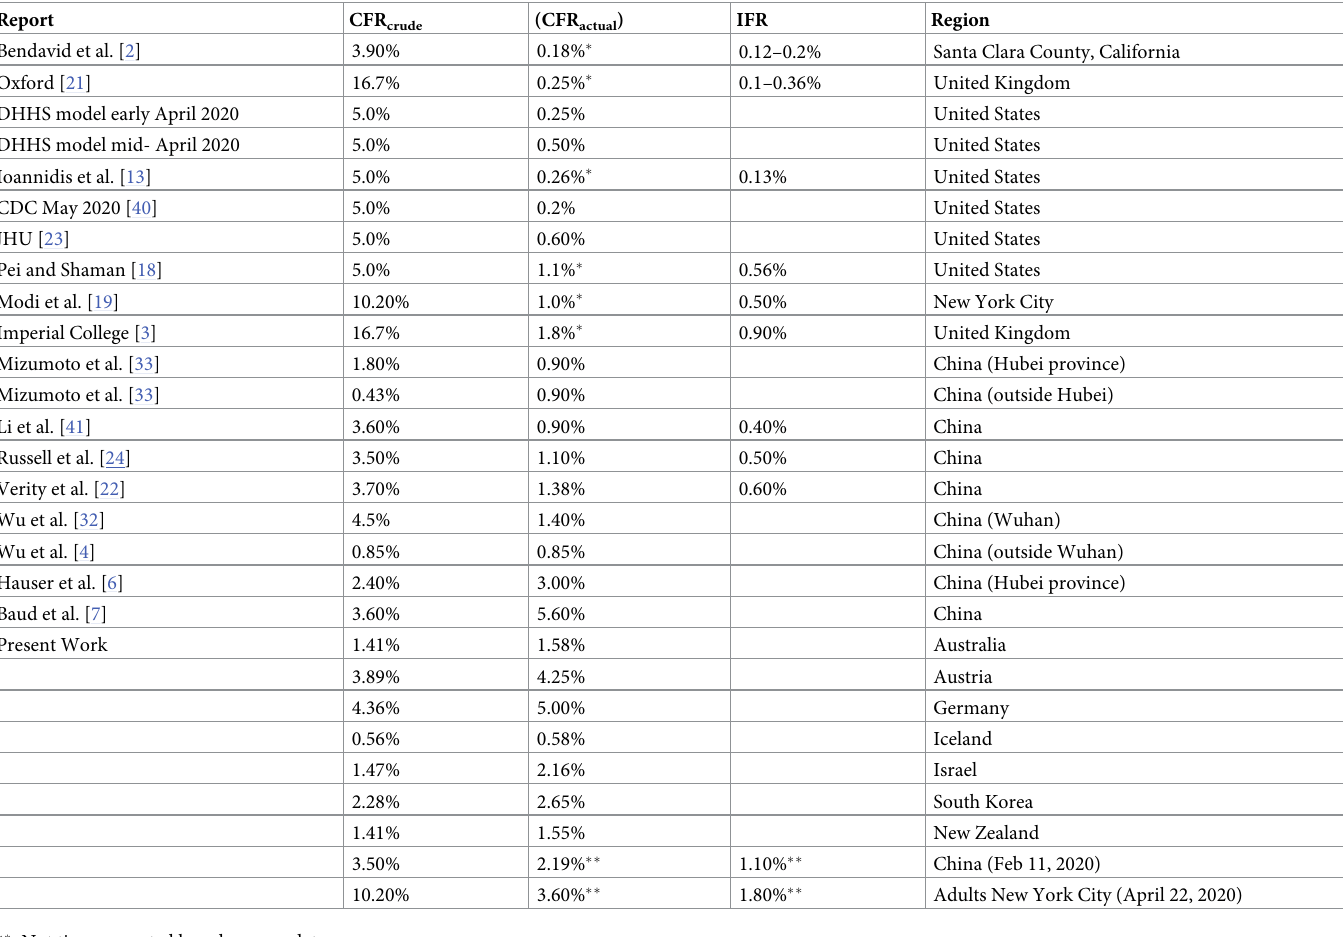
Table 1. Reported CFR crude , CFR actual , and corrected IFR values for China, the United Kingdom and the United States. The table summarizes CFR crude for each coun- try region at the time of the report, calculated CFR actual and IFR values through early May 2020. Details are available in the cited references [2, 4, 6–14, 16, 19, 21–24, 32, 33, 40, 41]. For the USA and UK the CFR crude on April 15, 2020 is listed. Studies are listed by their first author or by the location of the modeling group that reported